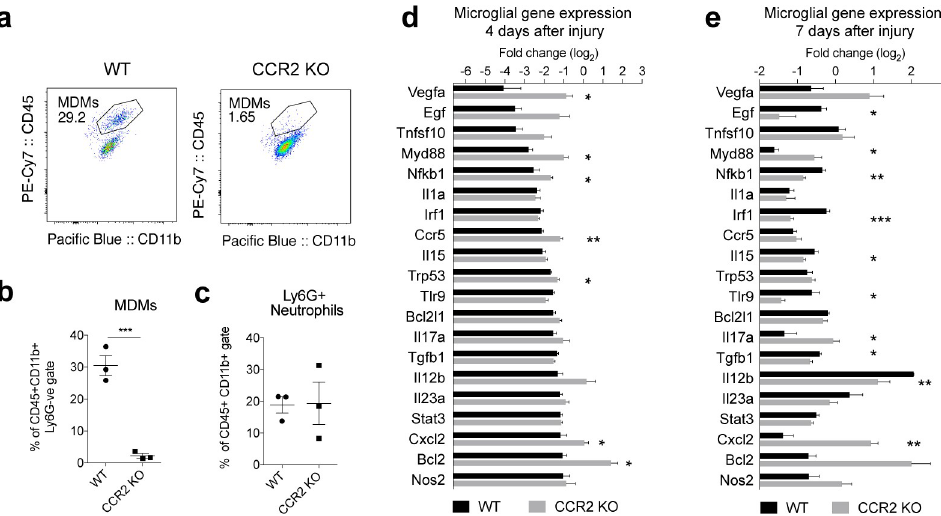
Fig 5. Lack of macrophage infiltration after SCI dysregulates microglial inflammation. Spinal cord contusion injury was performed in CCR2 (rfp/rfp) (CCR2 KO) mice and WT controls. ( a ) FACS plots show Ly6G − ve /CD45 hi /CD11b + MDMs in WT versus CCR2 KO mice five days after SCI. ( b ) Graph shows marked reduction in MDMs in the spinal cord lesion five days after SCI. ( c ) No change in Ly6G+ neutrophils in the injured cord at this time point (five days) post- SCI. ( d-e ) RT-qPCR gene array analysis of FACS-sorted microglia (CD45 low /CD11b +ve /Ly6G − ve /Ly6C − ve ) from WT and CCR2 KO SCI lesions four days ( d ) and seven days ( e ) after injury ( n = 3–4, 4–5 mice pooled per n ). ( d ) Graph shows the top 20 significantly down-regulated genes in WT animals compared with those genes in CCR2 KO mice. Each genotype was normalized to its own baseline control. ( e ) The same genes were assessed seven days after injury; several genes continue to show dysregulation compared with WT controls. Statistical analysis, Student t tests and one-way ANOVA. Mean ± SEM. � p < 0.05; �� p < 0.01; ��� p < 0.001. Corresponding raw data ( S1 Data ). CCR2, C–C chemokine receptor type 2; FAC, fluorescently activated cell sorting; KO, knock-out; MDM, monocyte-derived macrophage;